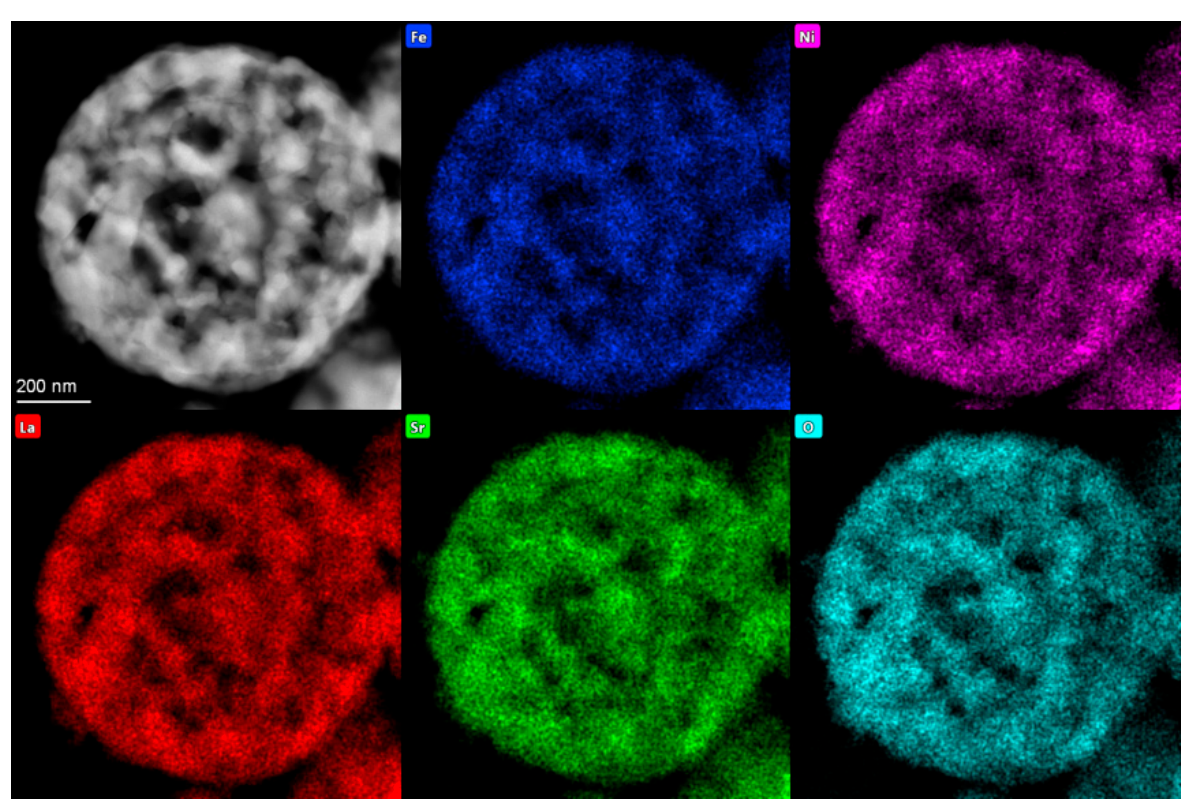
Figure 5. HAADF–STEM image of spherical hollow particles of LSNF with STEM-EDX elements’